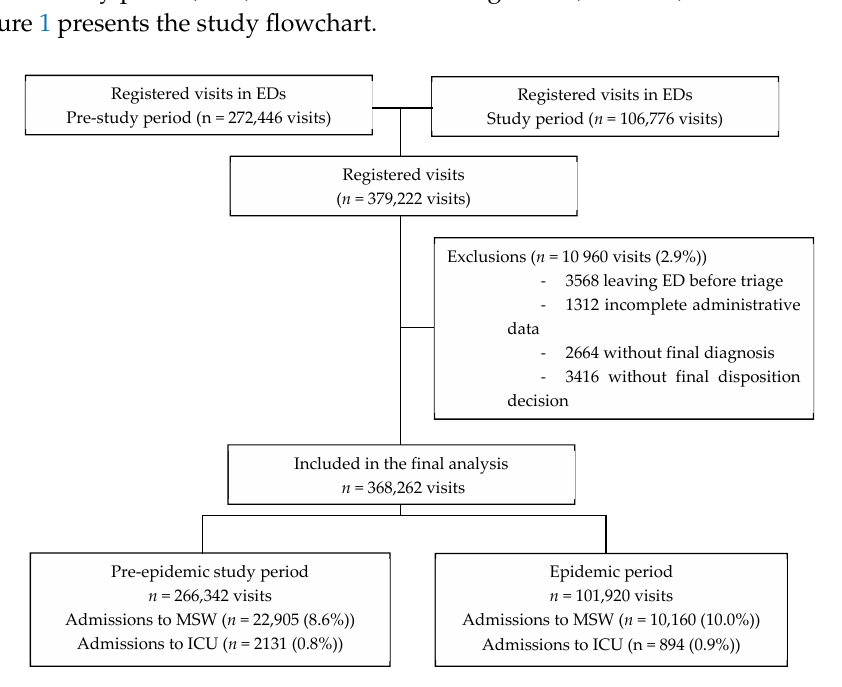
Figure 1. Flow chart. Legend: ED, Emergency department; ICU, intensive care unit; MSW, medical/surgical wards.